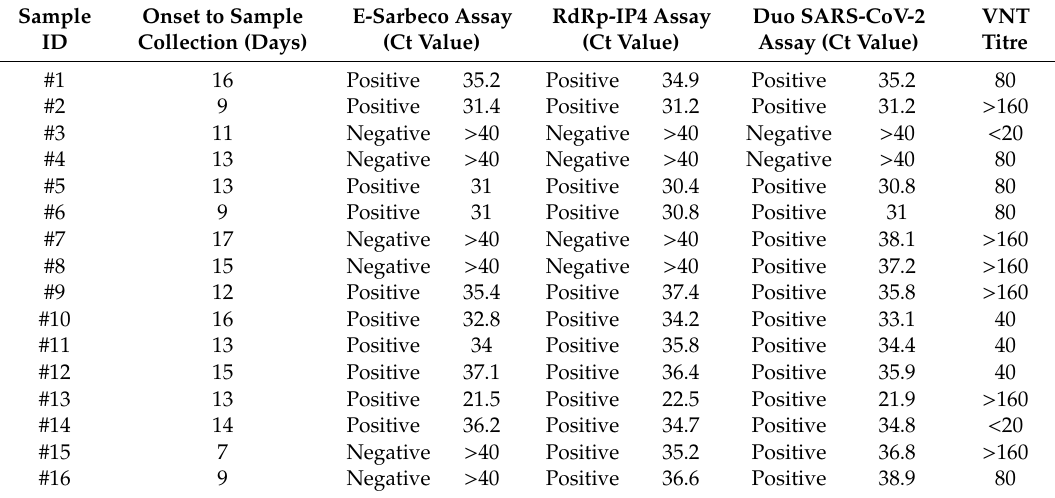
Table 3. RT-qPCR results observed on clinical samples collected from symptomatic individuals, tested with E-Sarbeco, RdRp-IP4 and duo SARS-CoV-2 assays. Highlighted in grey, samples with discrepant RT-qPCR